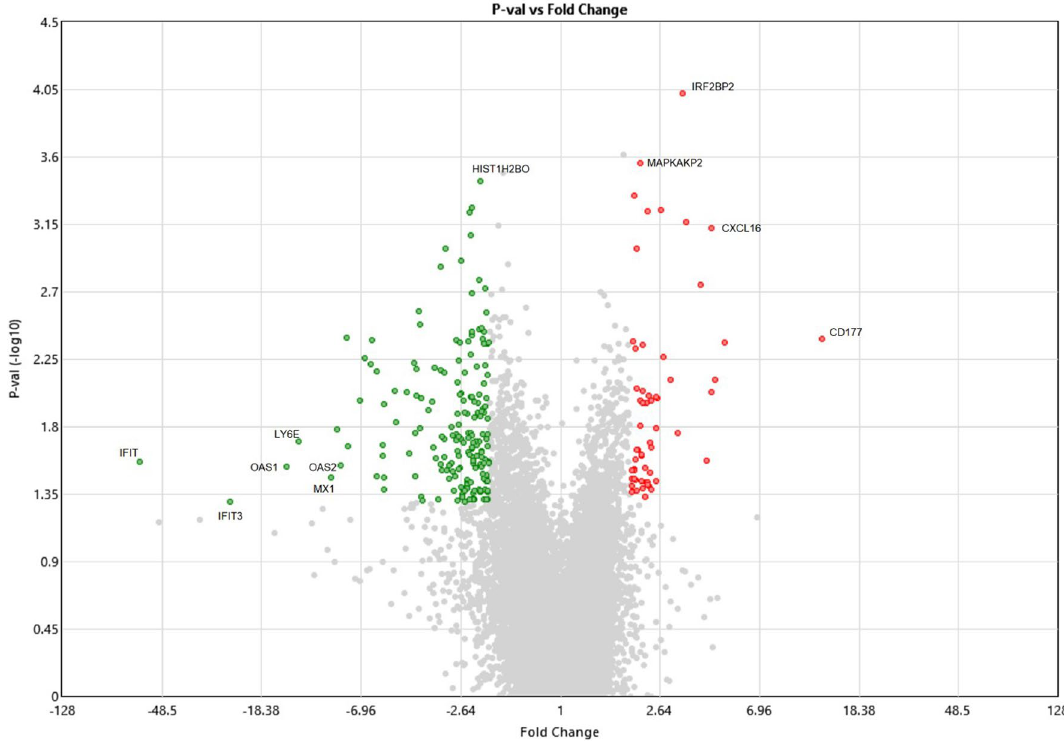
Figure 3. Differential regulation of ISGs between severe and mild Symptomatic COVID-19 cases. Volcano plot of Symptomatic ‘Severe’ vs ‘Mild’ COVID-19 cases. The log2 (FC) (fold change) is plotted on the x-axis, and the negative log10 (FDR) (p-value) is plotted on the y-axis. The red points on the plot show Upregulated expression (n = 53 genes), Downregulated genes (n = 183) are shown in green. Analysis with the absolute value of log2 (FC) not less than 1 (FC = 2) and FDR values less than 0.05. Genes which have a p < 0.05 ANOVA with Benjamini– Hochberg FDR are illustrated. Selected highly differentially regulated genes are